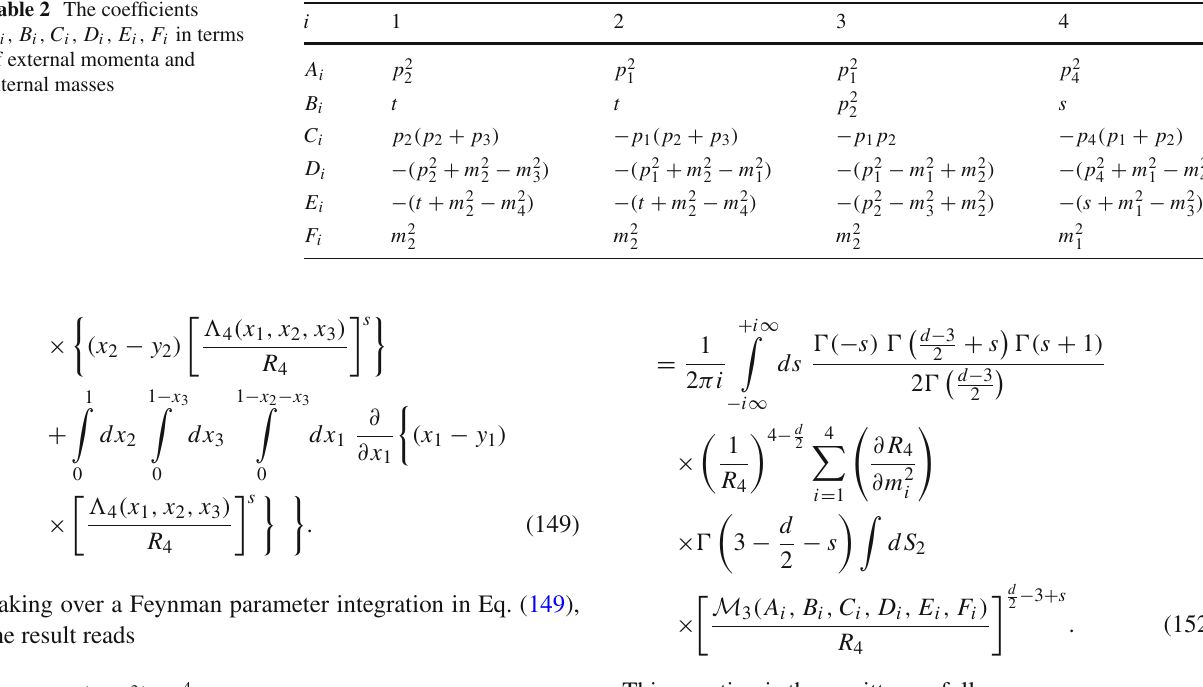
Table 2 The coefficients A i , B i , C i , D i , E i , F i in terms of external momenta and internal